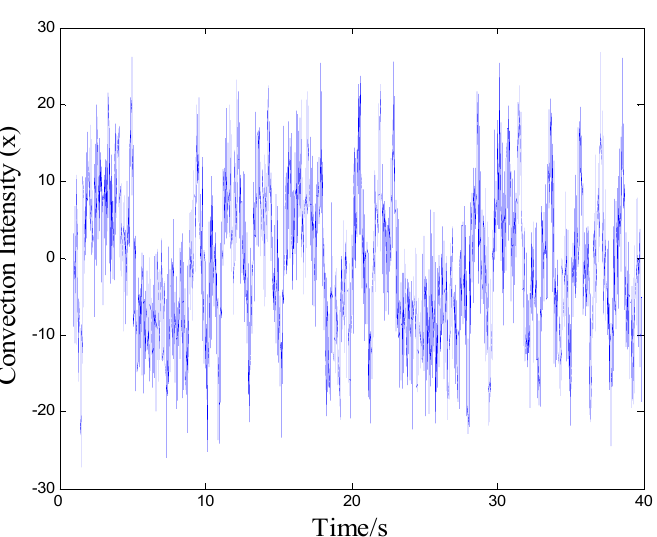
Figure 8. 𝑥(𝑡) of Lorenz signal Figure 8. x ( t ) of Lorenz signal.